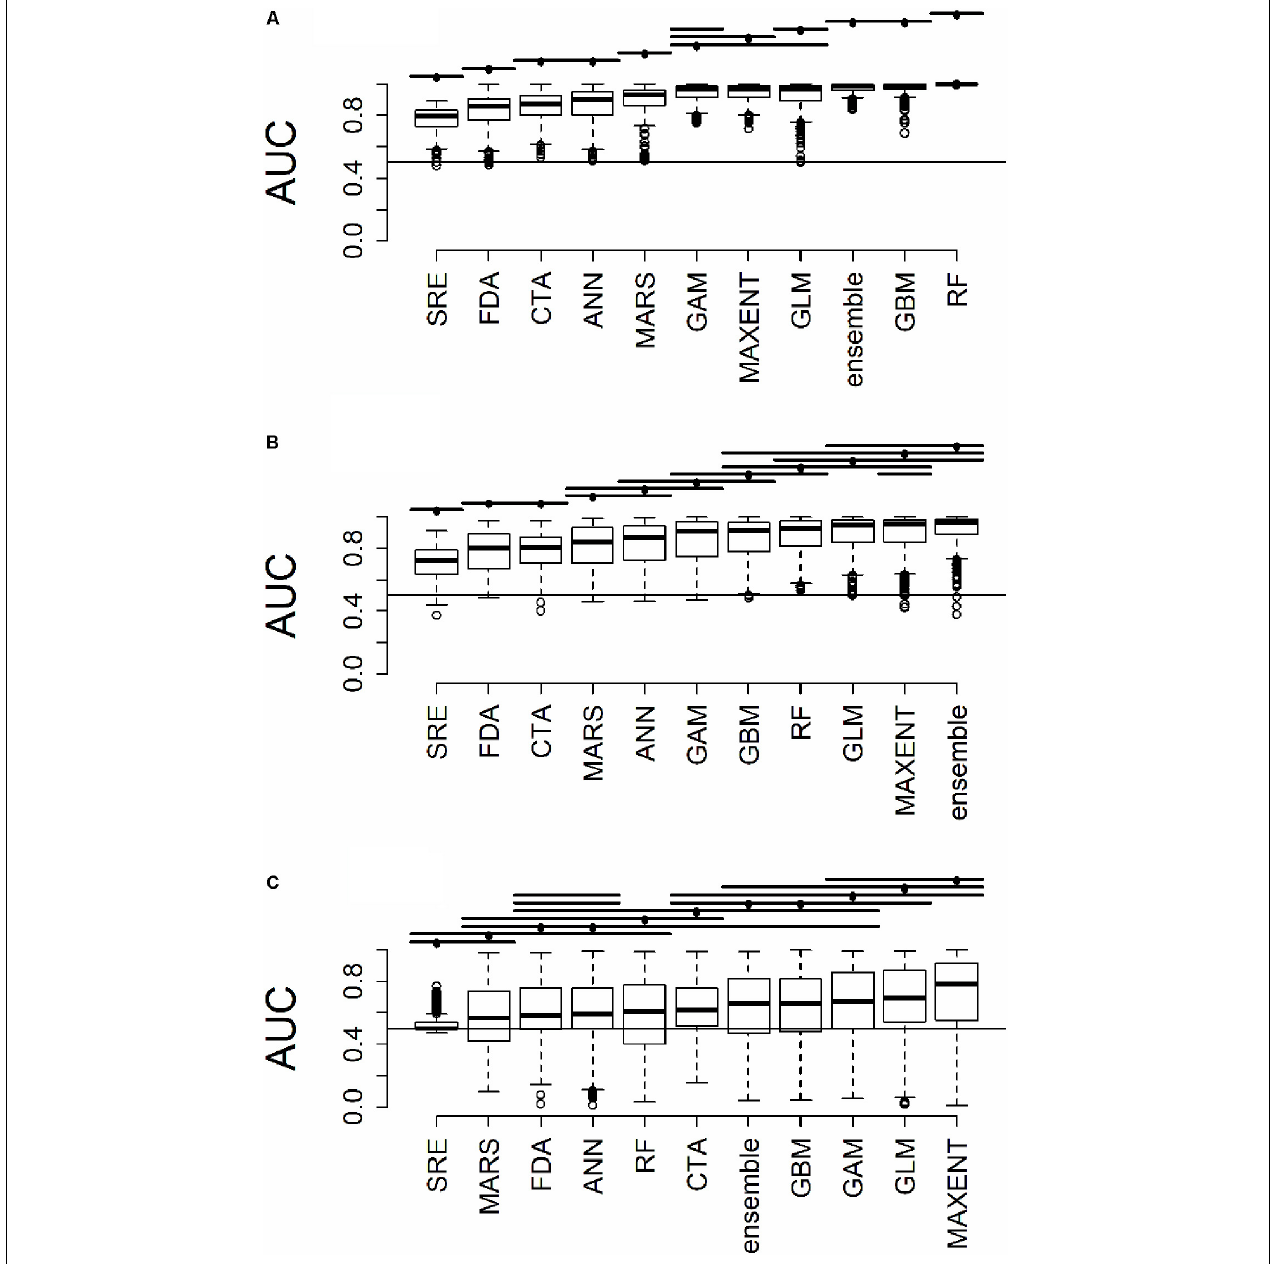
FIGURE 3 | Distribution of AUC for model predictions (A) across all plots used to train the algorithms (B) at testing plots not used to train the algorithms, but within the same geographic extent as the training data, and (C) in a novel geographic extent. Horizontal bars above the boxplots represent significant Tukey post hoc groups. Black dots within the Tukey group bars represent the reference algorithm – all algorithms beneath a given bar are not significantly different from the reference algorithm for that bar. Multiple black dots on a given bar indicate that the Tukey groups are identical for multiple algorithms.